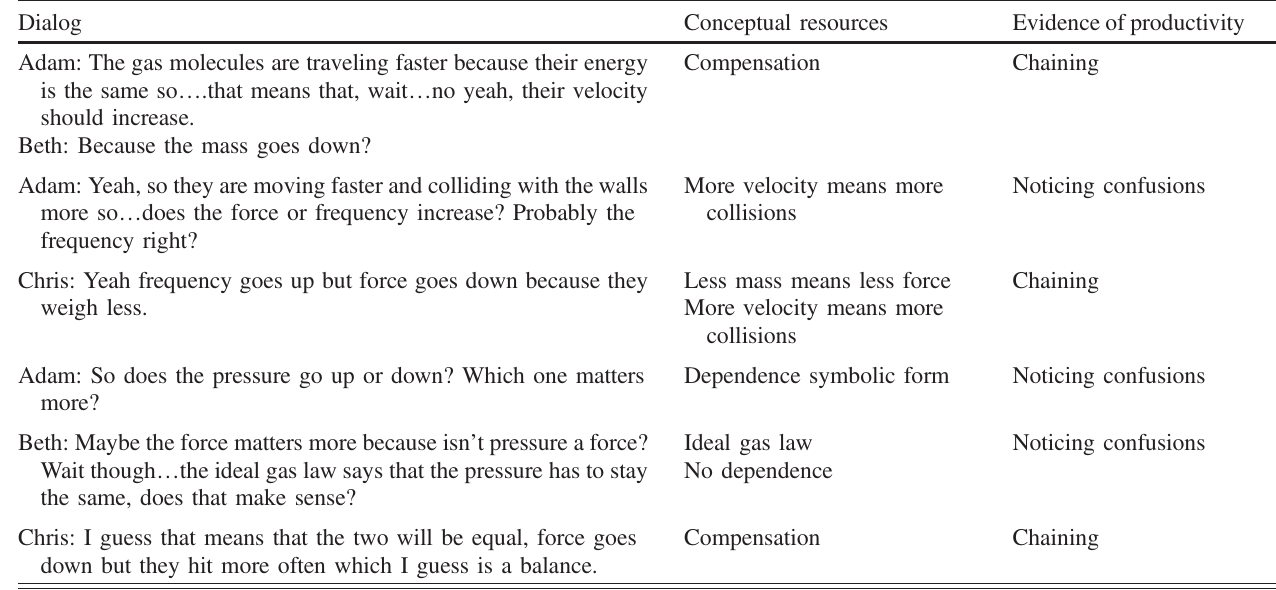
TABLE V. Changing gas conversation A. Dialog